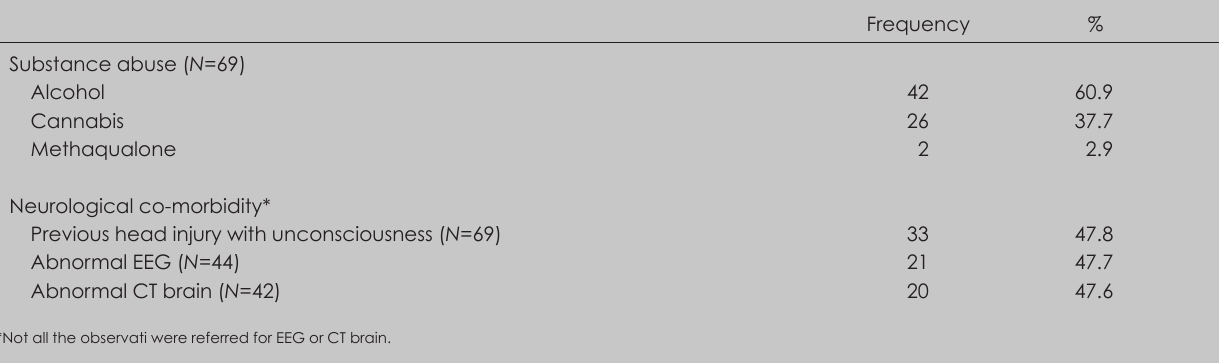
Table III. Substance abuse and neurological co-morbidity of participants